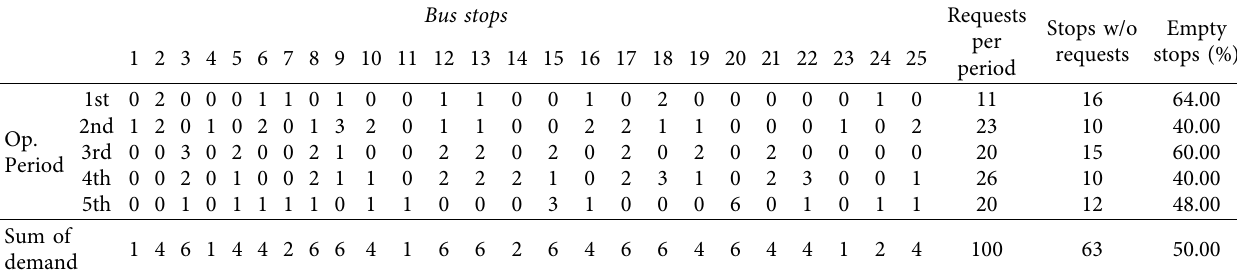
Table 3: Example of demand distribution in the operation horizon, corresponding to fve operation periods. Bus stops